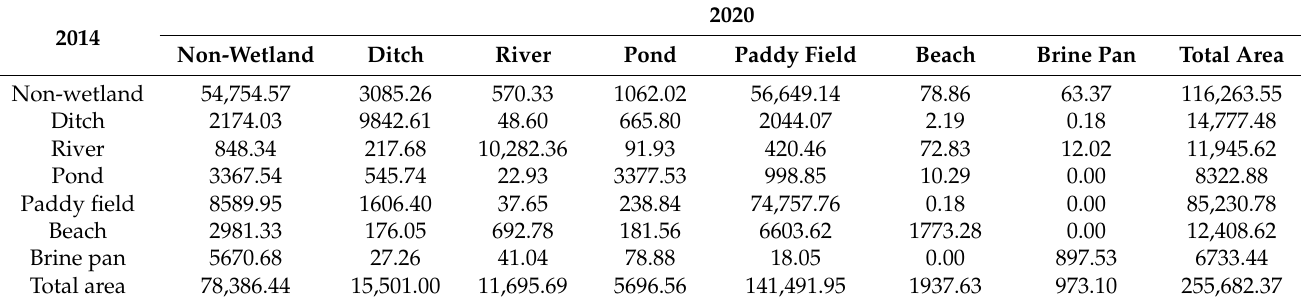
Table 7. Area of landscape conversion matrix from 2014 to 2020 (hm 2 ).